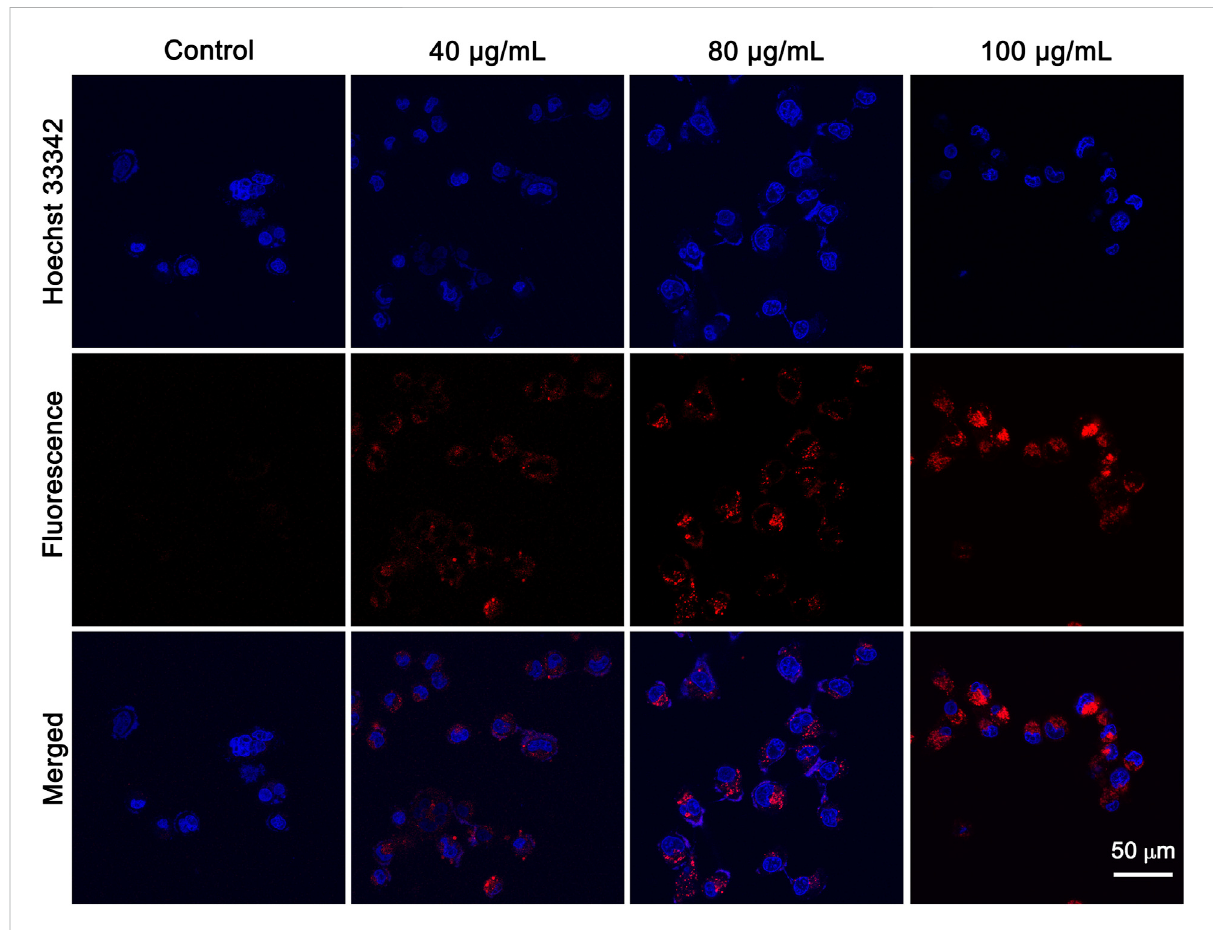
FIGURE 5 CLSM images of HeLa cells treated with DMEM, 40 and 80 μ g/ml of IR820@PDA@PEG NPs. CLSM images were obtained at a ×60 objective. λ λ – 1,000 nm. Scale bar = 50 ex = 640 nm, em = 800